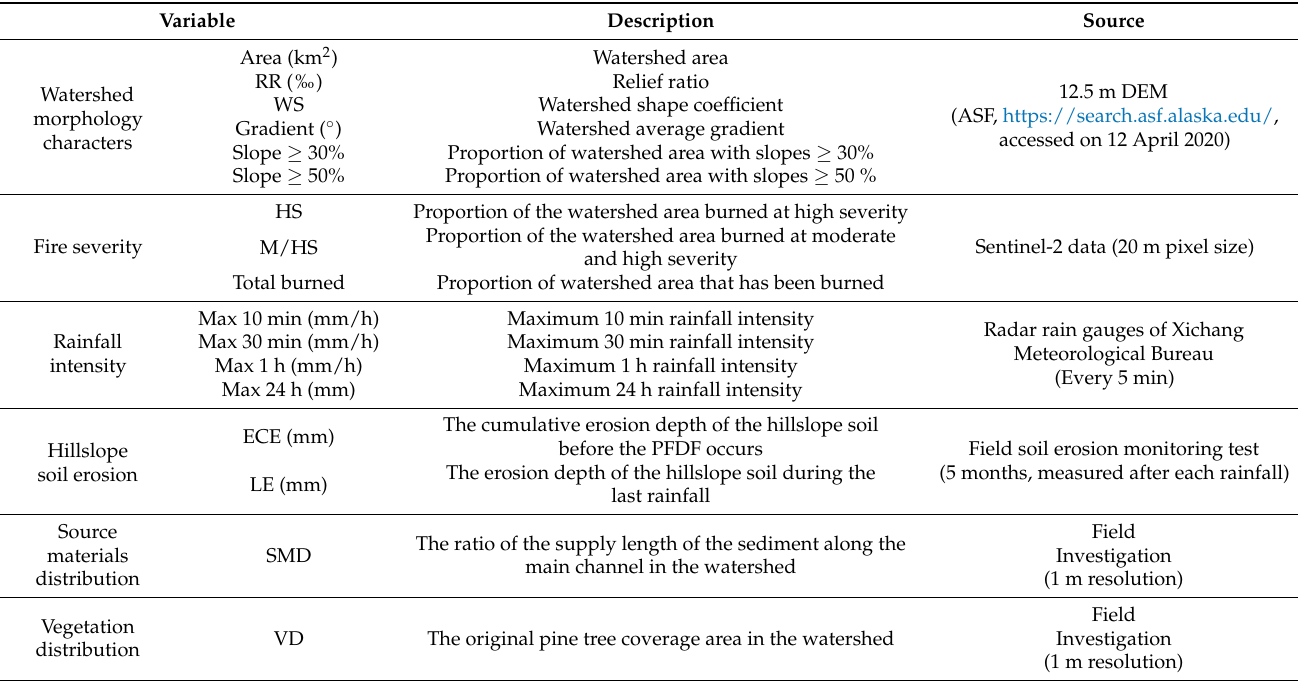
Table 1. Description and source of the influence variables of post-fire debris